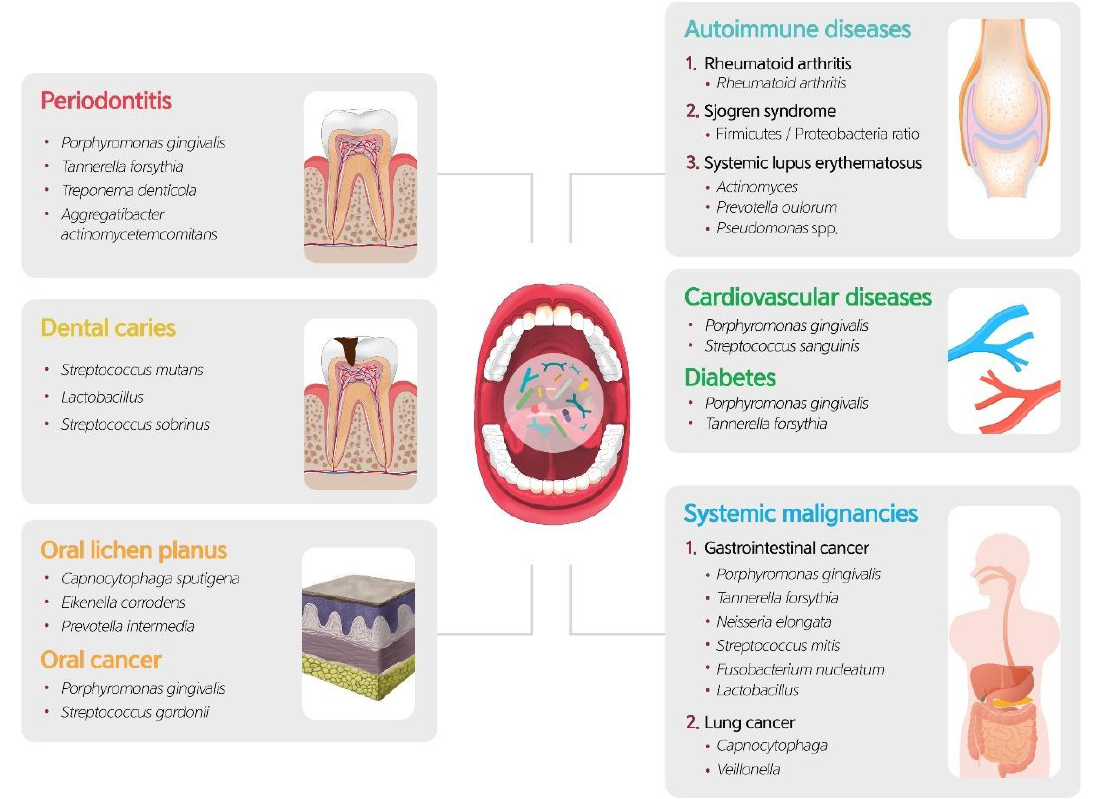
Figure 6. Types of systemic diseases related to dysbiosis of the oral microbiome.